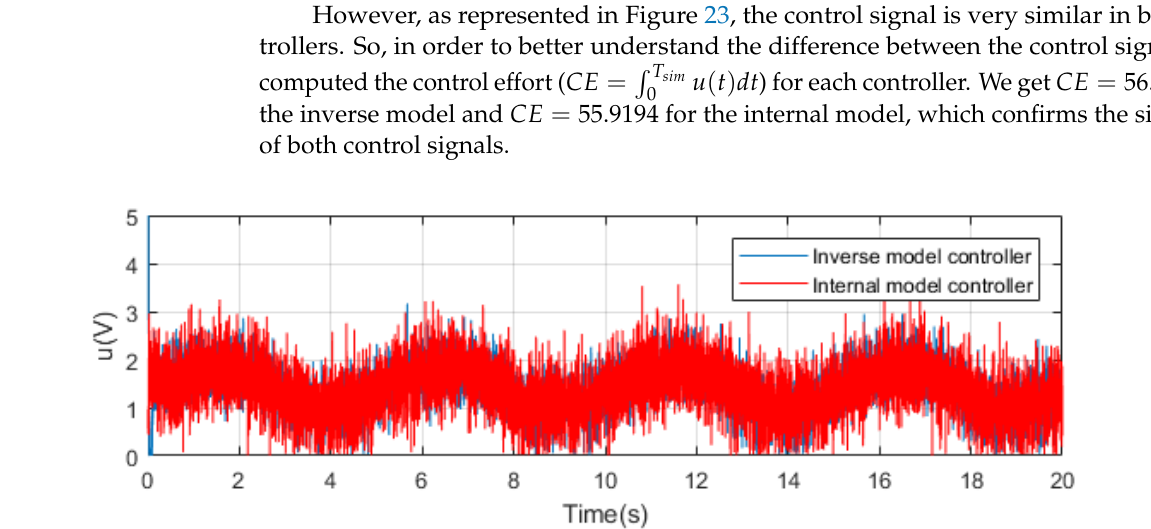
Figure 23. Control signal applied by the inverse model with adaptive block and internal model for the sinusoidal reference.